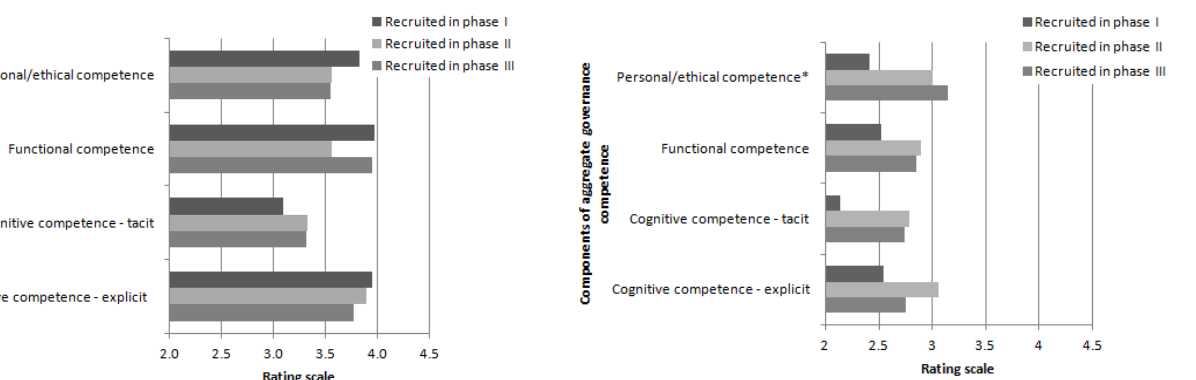
Fig. 9. Components of aggregate governance competence perceived to be required in daily work, in phase I (1970–1987), II (1987–1998) and III (1998–present); rating scale from 1 to 5, where 1=not at all, 3=to some extent, and 5=extensively.